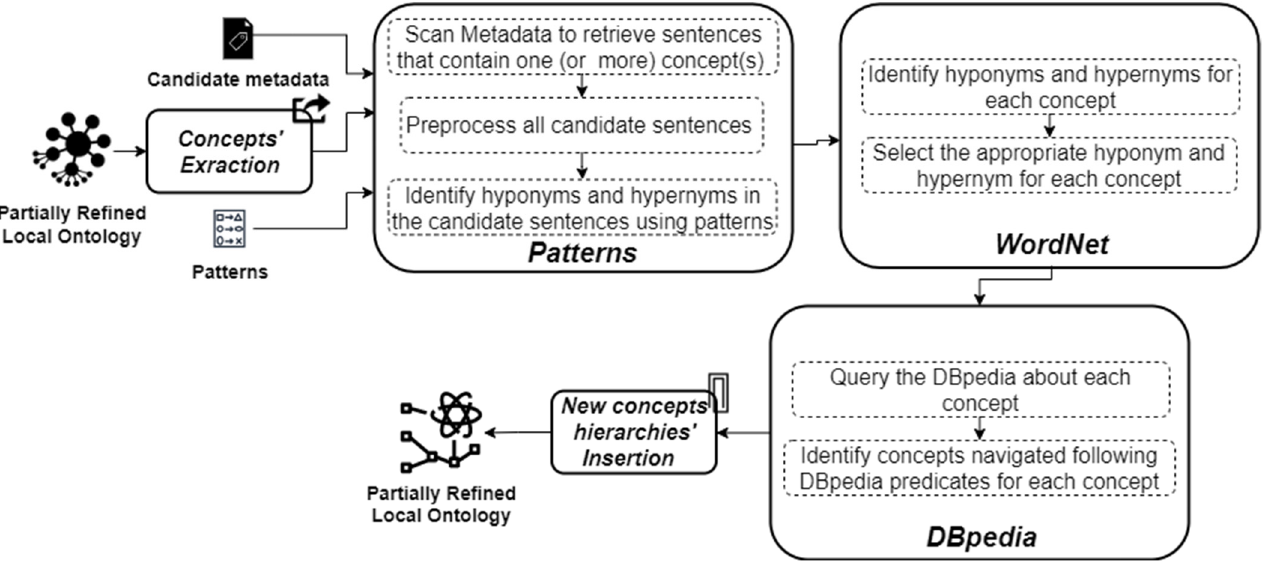
Figure 3. Taxonomic relation refinement method.